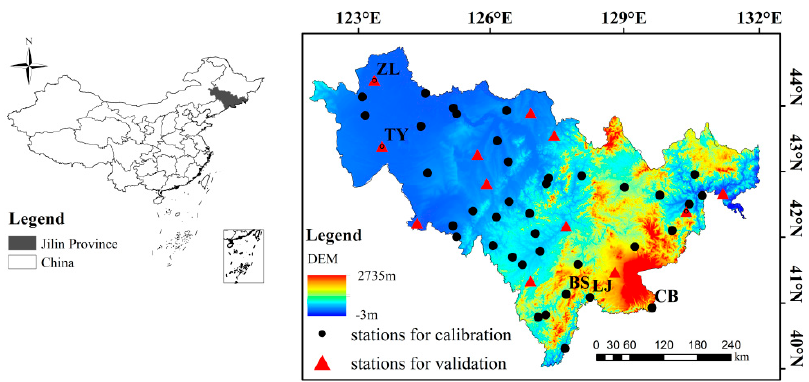
Figure 1. The location of the study area in China.